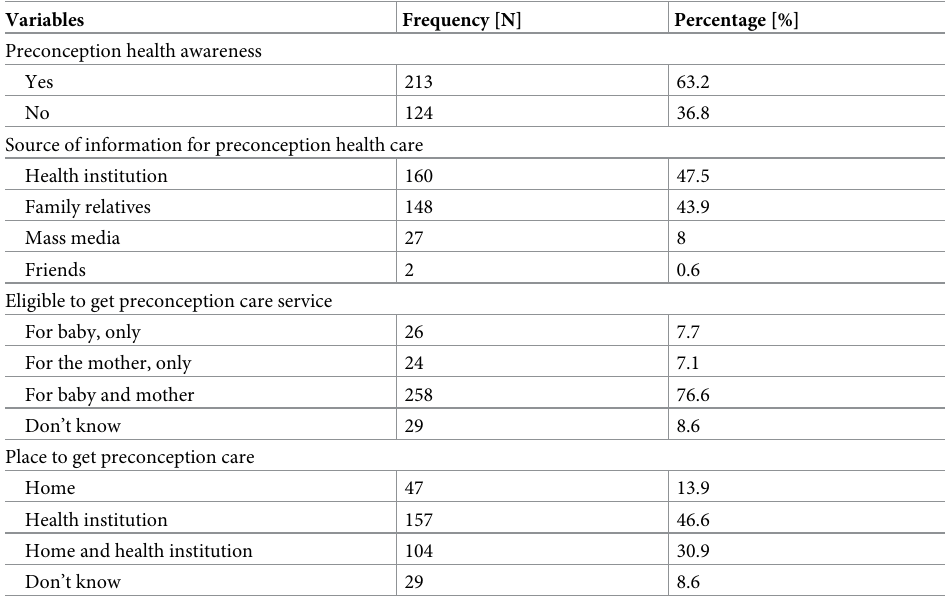
Table 2. Women’s awareness of preconception health care in Jinka town, Southern Ethiopia, 2018 [n =